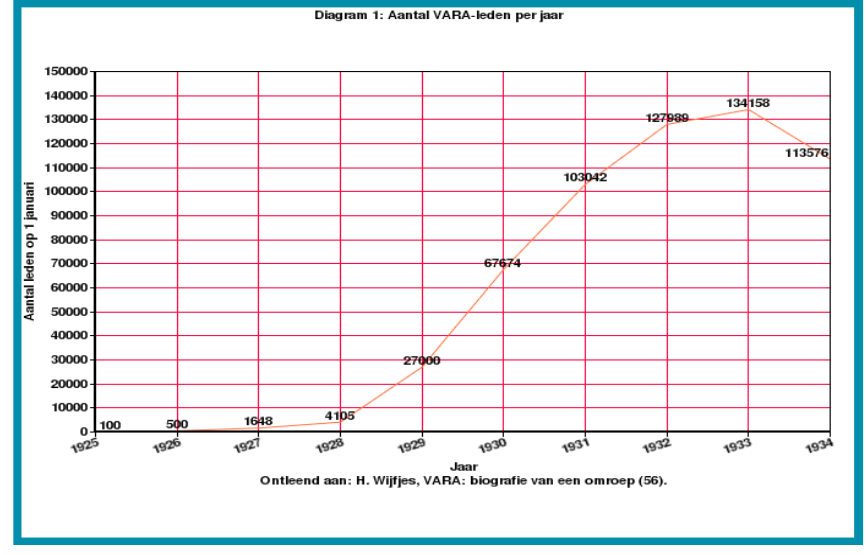
Number of VARA members per year. Vertical axis: number of members on 1